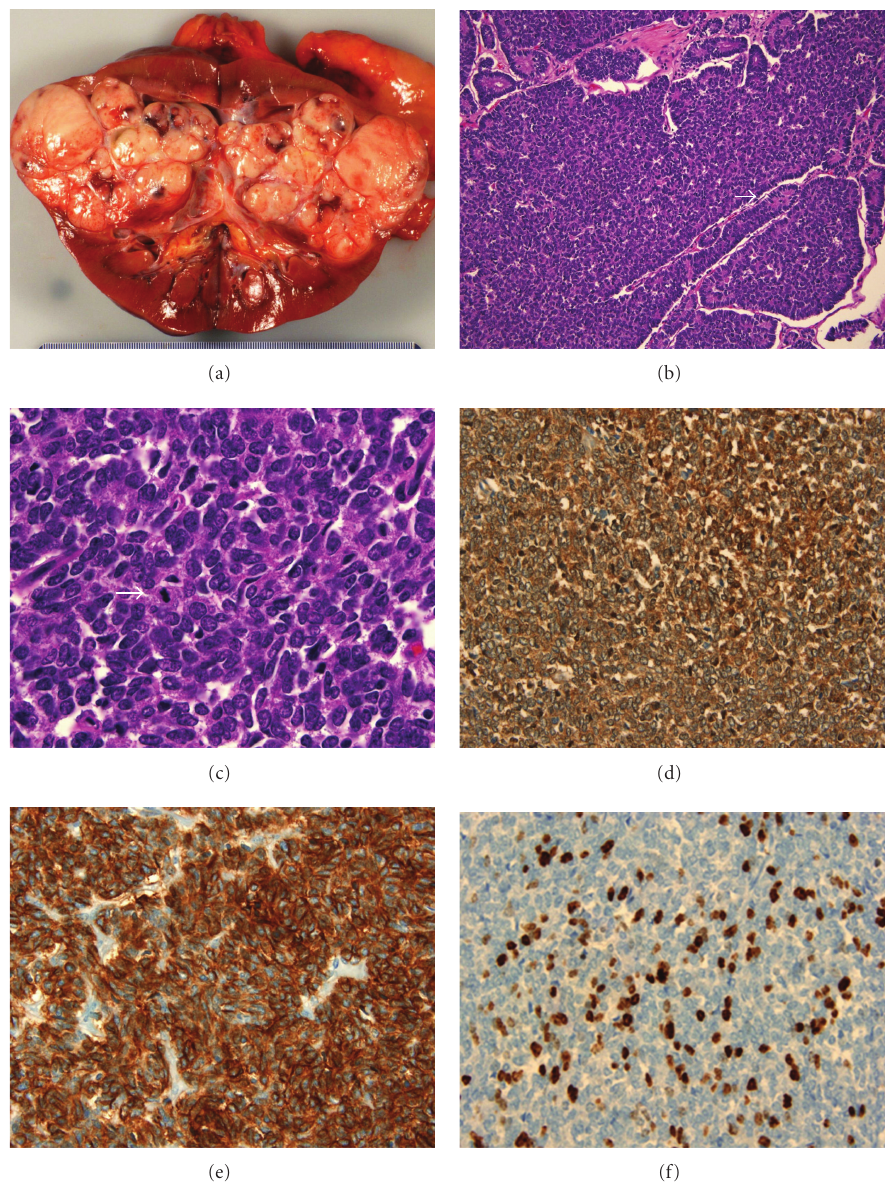
Figure 1: Thirty-two-year-old patient, right-sided laparoscopic radical nephrectomy. (a) Gross picture of the right kidney showing an 8.3cm encapsulated tumor located at the pelvic adipose tissue within the renal capsule. (b) Microscopic photography of the tumor showing tumor cells arranged in solid sheets, tightly packed cords, and trabeculae with variable stroma. Tubular structures (arrow) can be identified in the periphery of the cell nests (HE × 20). (c) High power view of the tumor cells showing uniform small round blue cells with scant cytoplasm, uniform nuclei, and stippled chromatin. Mitotic activity (arrow) was present (HE × 100, oil). (d) The tumor cells were strongly positive for NSE in a cytoplasmic stain (DAB X50). (e) Strong membranous and cytoplasmic stain for CD56 (DAB X50). (f) Ki 67 shows a high proliferation rate index of 30% (DAB